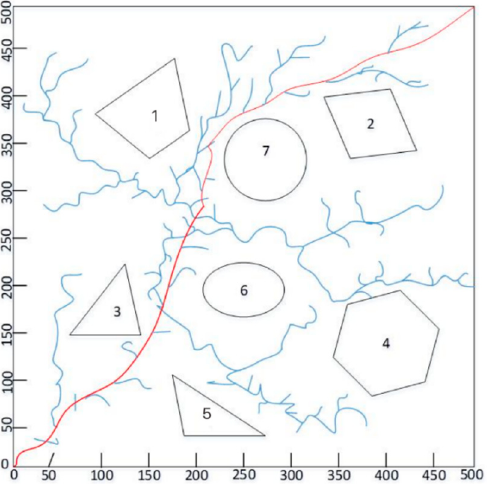
Figure 12. Result of path planning according to dynamic step size.